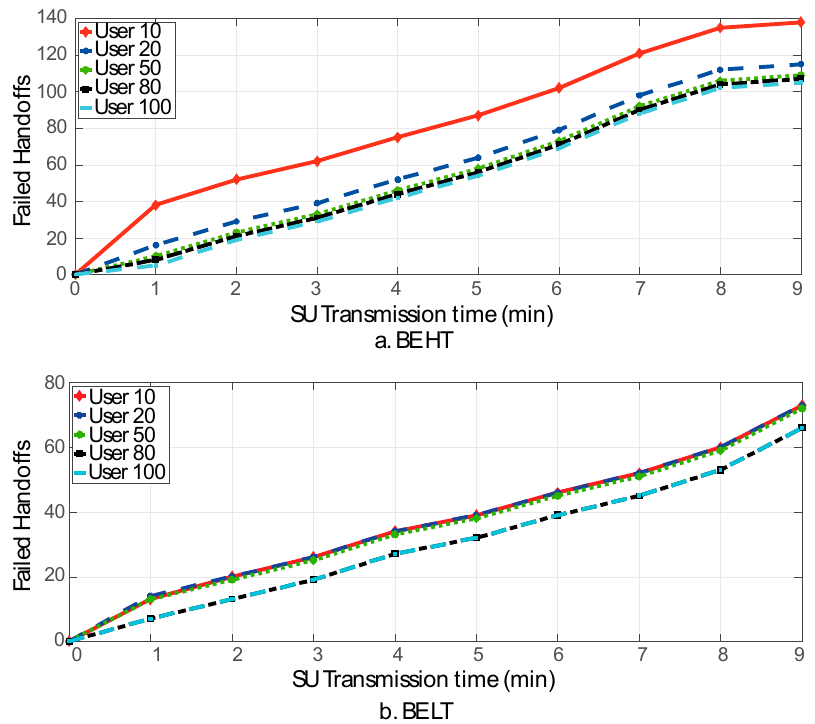
Figure 18. Failed handoffs for SAW: ( a ) Best effort (BE) and high traffic (HT); ( b ) Best effort (BT) and low traffic (LT).